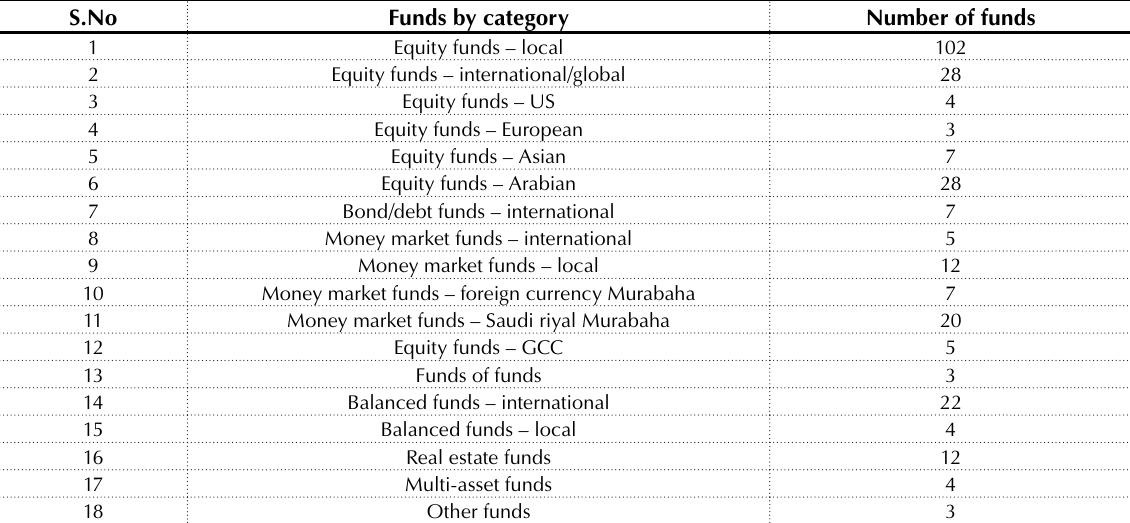
Table 1. Category wise funds domiciled in Saudi Stock